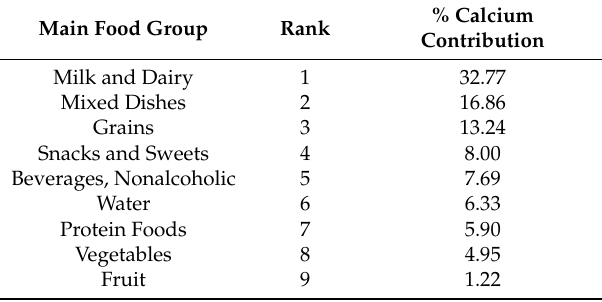
Table 4. Food sources of calcium contribution in the total U.S. diet, adults ≥ 51 years old ( n = 4522; gender combined; daily intake data; NHANES 2011–2014; main food groups contributing <1.0% not reported; data are Day 1 intakes).